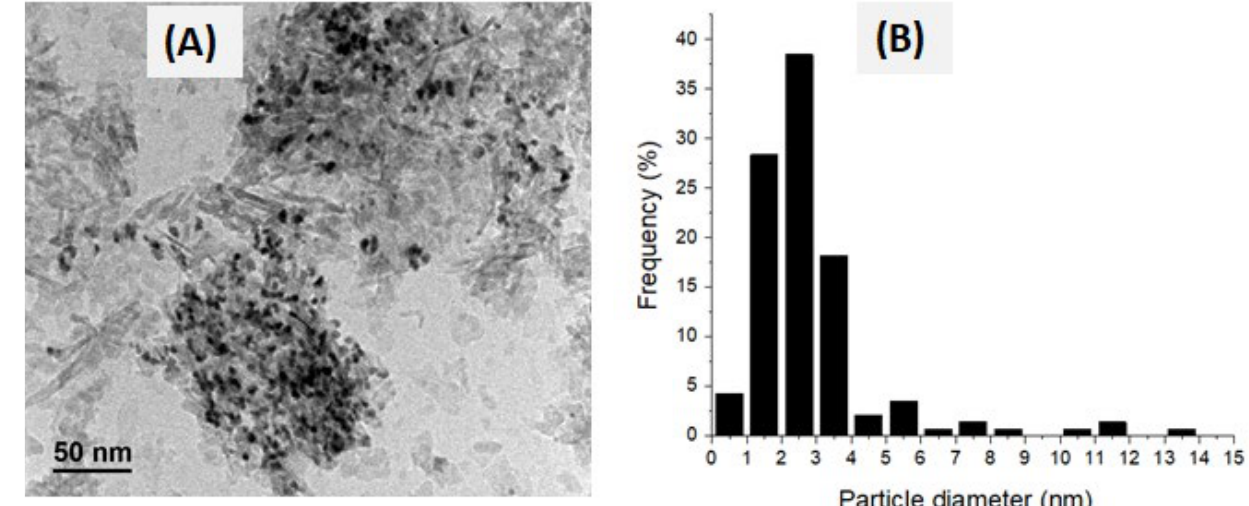
Figure 1. ( A ) TEM picture of the Pt/alumina and ( B ) corresponding particle size distribution. The 1.3 wt% Pt/TiO 2 catalyst shows Pt nanoparticles well-distributed over the